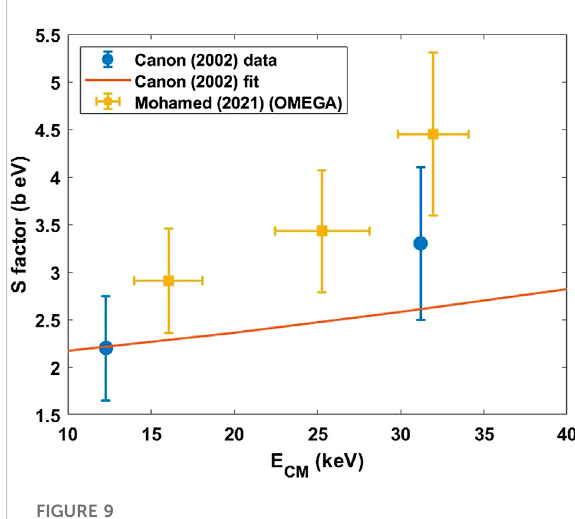
FIGURE 9 Comparison between OMEGA (GCD-1) S factor measurements for H(T, γ ) 4 He and accelerator measurements for this reaction at similar energies. The accelerator data is from Ref. 52, whichprovides twodata points atincident beam energies of 40 and 80 keV (or E CM = 12.3 and 31.2 keV) as well as a fi t to these two data points along with data from Refs. 45 and 46. The OMEGA data points appear to agree with the data points from Ref. 52, though they are higher than the fi t which included the data at higher CM